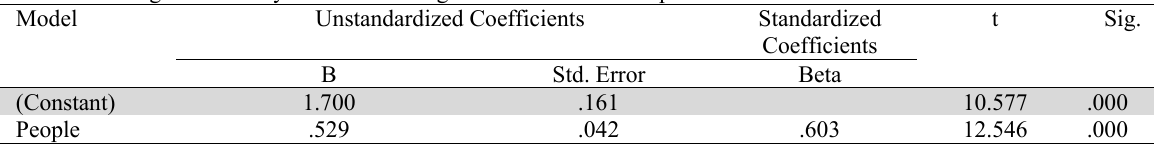
The results of regression analysis for examining the effect of leadership on customer culture